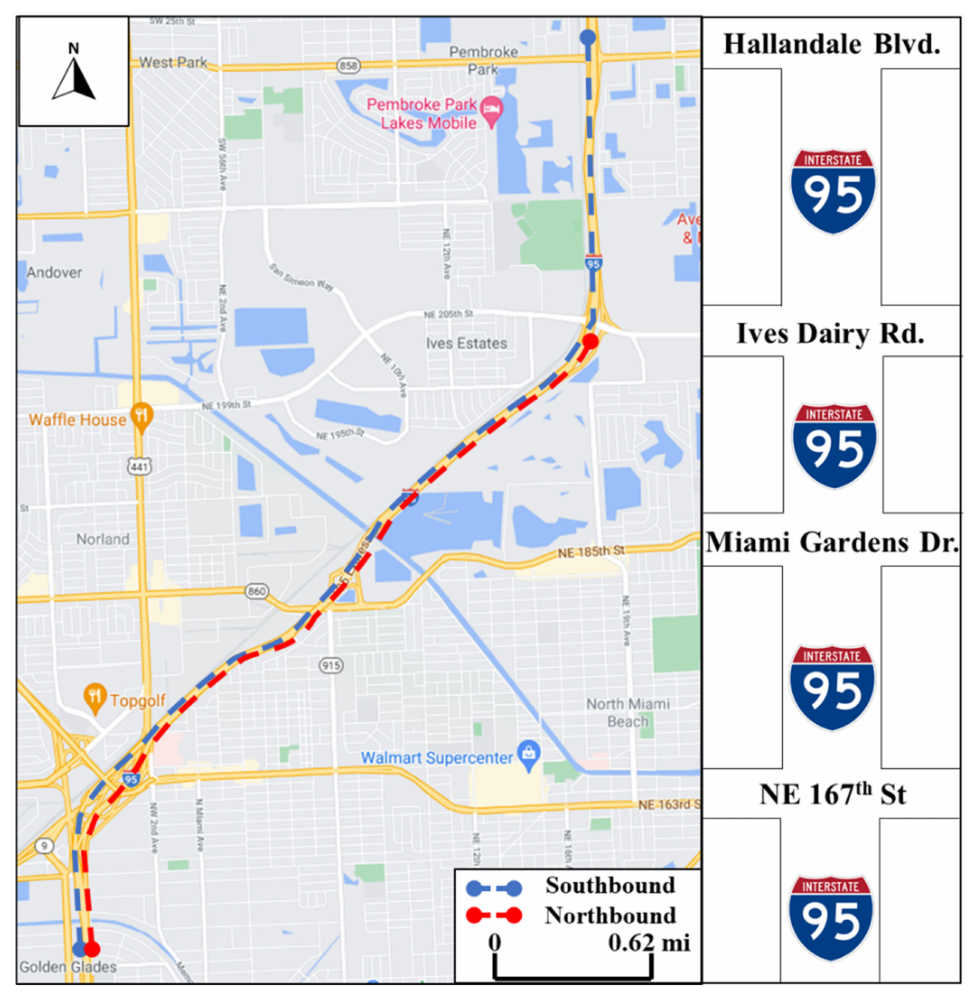
Figure 1. Study area of I-95 express